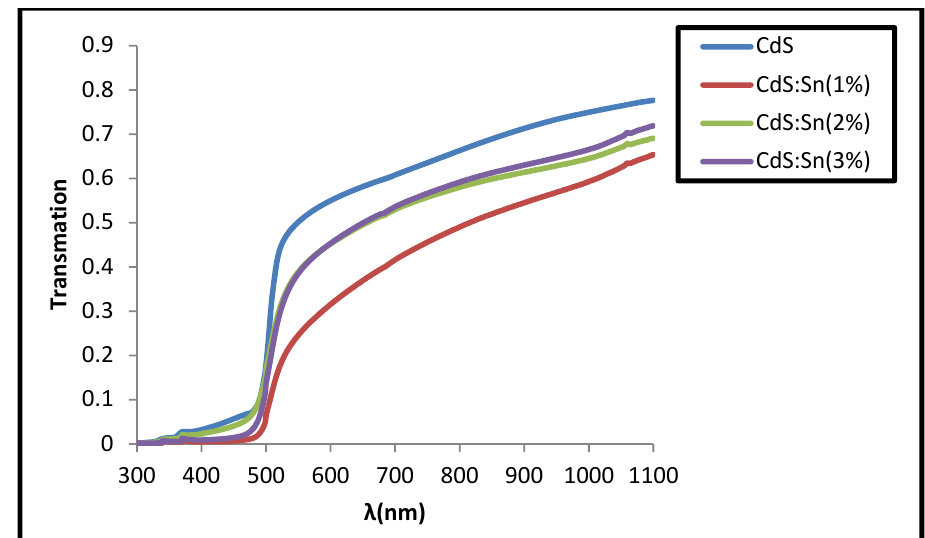
Fig. 2: Transmission spectrum of CdS and CdS:Sn thin film.